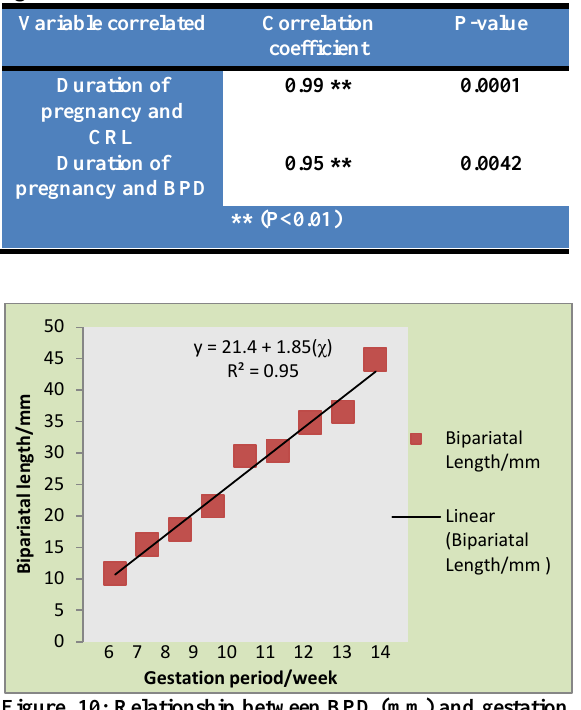
age with CRL and BPD.